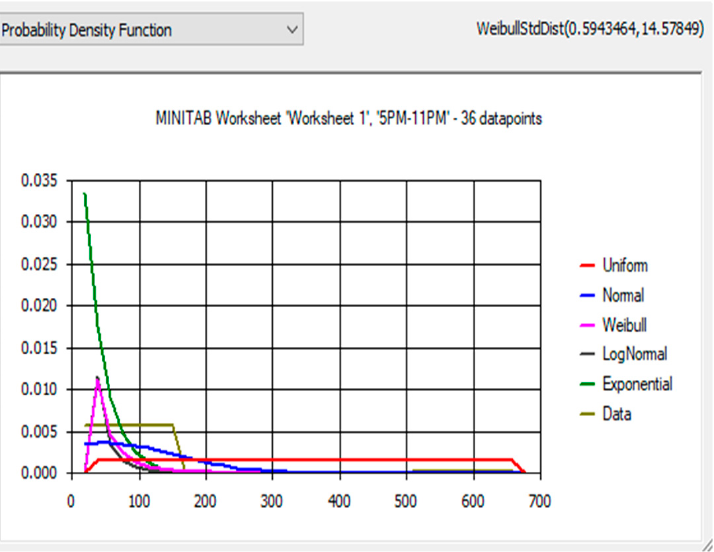
Figure 14. The lowest error in expected EVs’ service time is exponential during the period [5 Am: 11 Am].